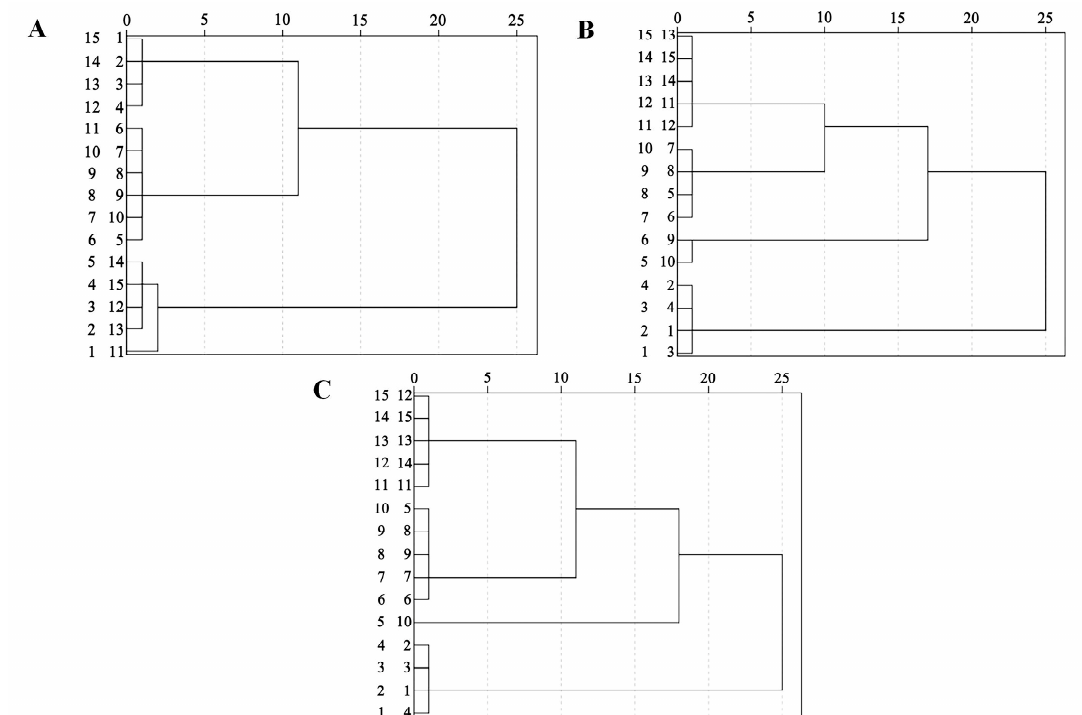
Figure 5. Cluster analysis (CA) of pasteurized milk. Labels 1, 2, 3, 4, and 5 represent the control sample milk. Labels 6, 7, 8, 9, and 10 represent the homogenized sample milk at 150-bar pressure. Labels 11, 12, 13, 14, and 15 represent the homogenized sample milk at 300-bar pressure. Cluster analysis (CA) of 8-h pasteurized milk ( A ). CA of 72 h pasteurized milk ( B ). CA of 168-h pasteurized milk ( C ).